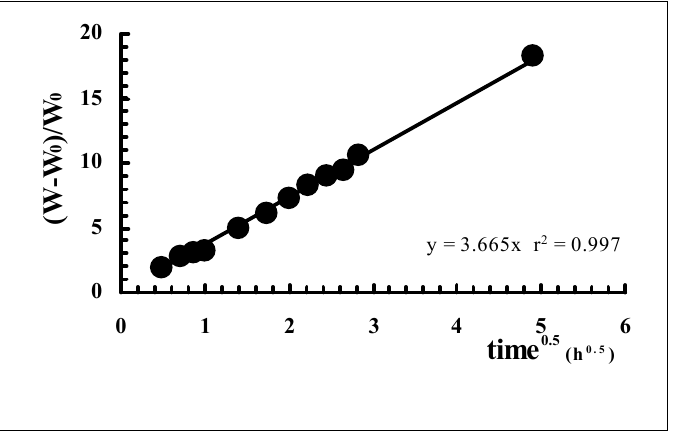
Figure 15. Water uptake data, relative to tablets of Sclg/borax, as a function of square root of time in distilled water (pH= 5.4) at 37 °C.